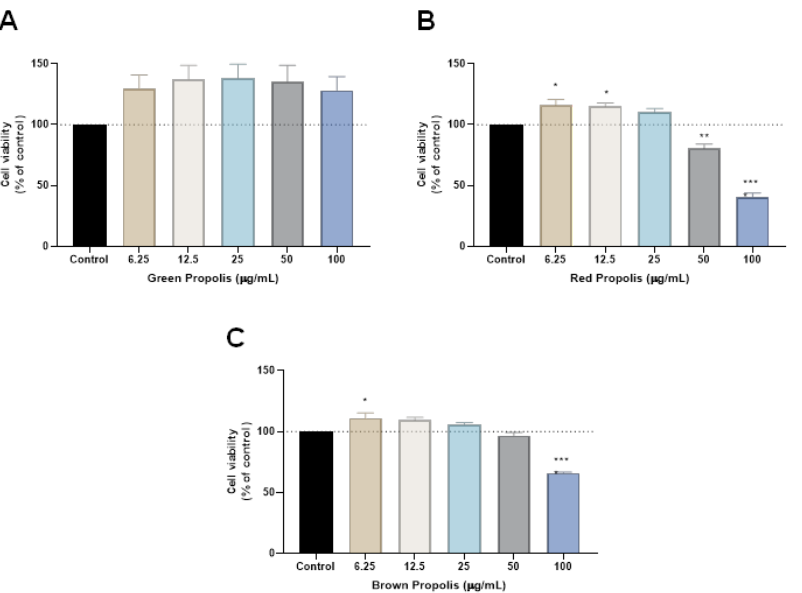
Figure 2. Cell viability of HT-29 colon cancer cells treated with ( A ) green propolis, ( B ) red propolis and ( C ) brown extracts alone. Cultured cells were seeded in 96-well plates and exposed to each extract (6.25–100 μg/mL) for 48 h. Cell viabilities were determined after the final treatment by MTT assay. Each point represents the mean ± SEM relative to the control untreated cells. * Statistically significant vs. control at p < 0.05. ** statistically significant vs. control at p < 0.01. *** statistically significant vs. control at p < 0.001.